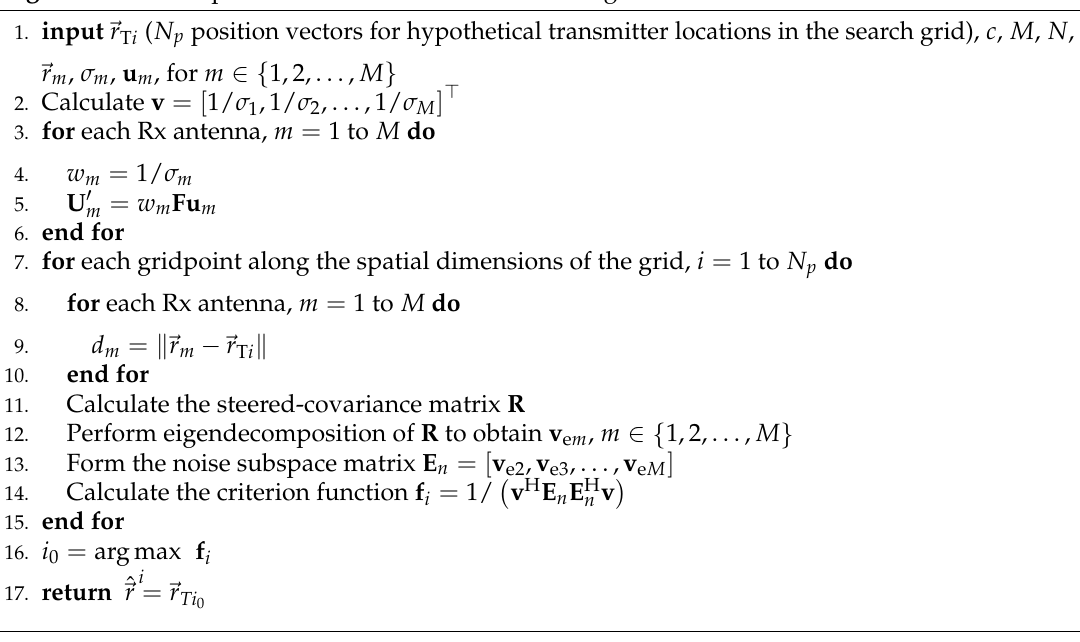
Algorithm 3 An implementation of the SCM-MUSIC